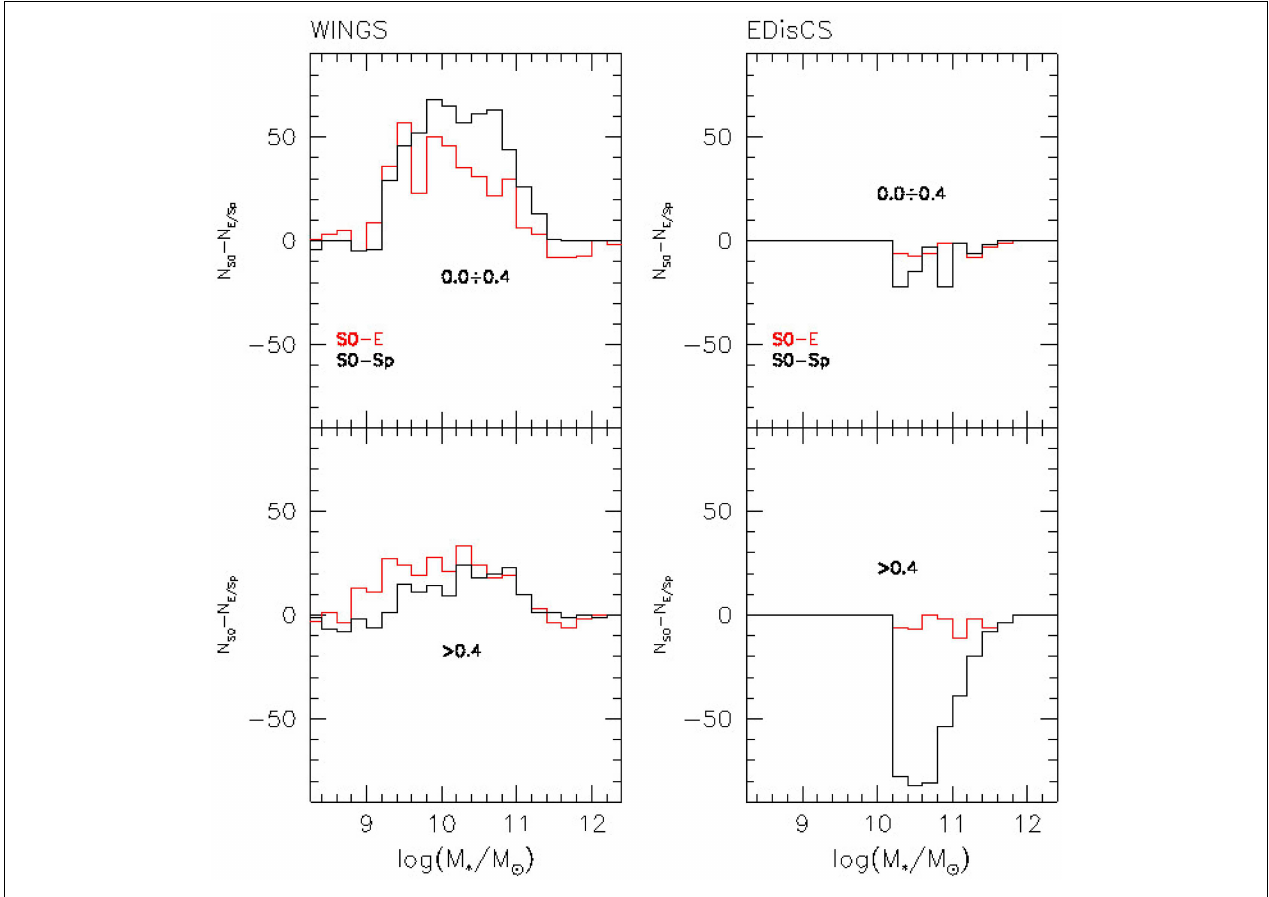
in each bin of galaxy mass. The right panels show the same difference for the EDisCS data sample. The red lines mark the same distributions for the difference between the number of S0’s and